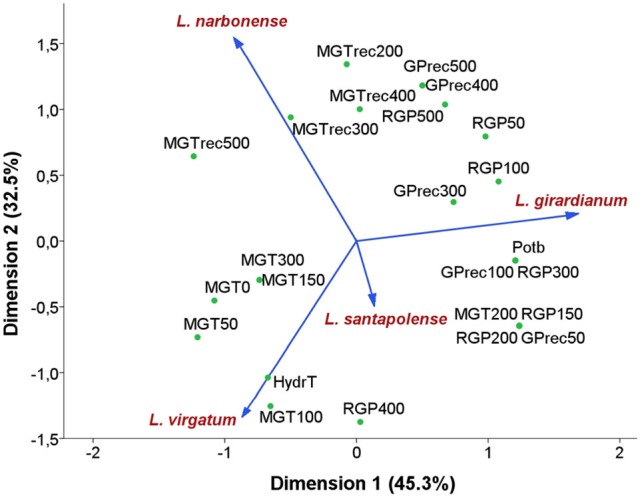
Ordination plot of the four Limonium species using Nonlinear Principal Components Analysis (NLPCA). Species are indicated by vectors. Abbreviations of the indicated variables: RGP, reduction of germination percentage; MGT, mean germination time; GPrec, germination percentage in recovery; MGTrec, mean germination time in recovery; Potb, base osmotic potential; HydrT, hydrotime. Numbers in acronyms indicate the tested NaCl concentrations.